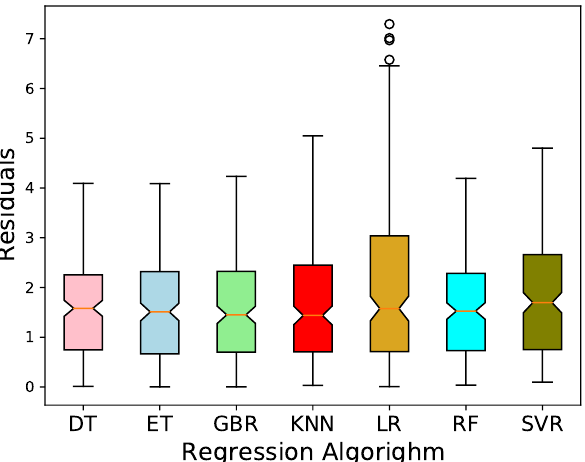
Figure 5. Error bound analysis, where the residuals are computed by taking absolute difference of true and estimated